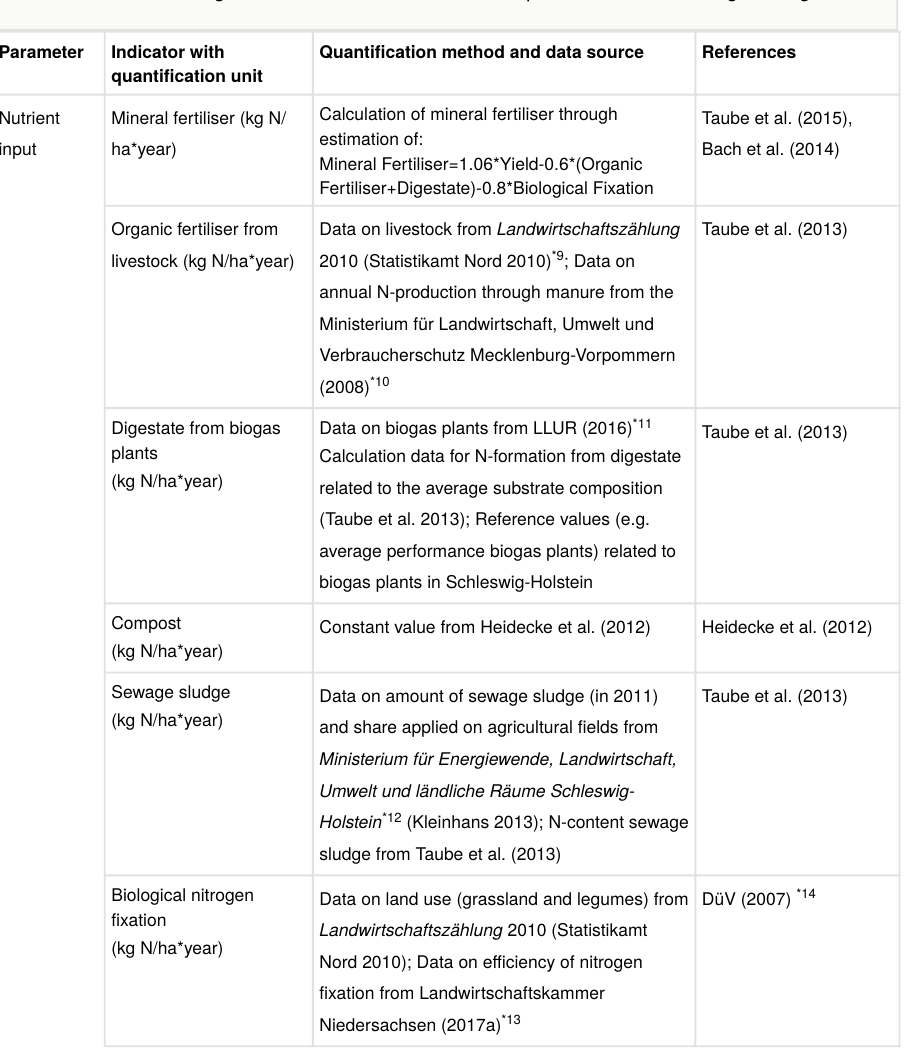
calculated nutrient budgets. Data from the Landwirtschaftszählung 2010 (Statistikamt Nord 2010)